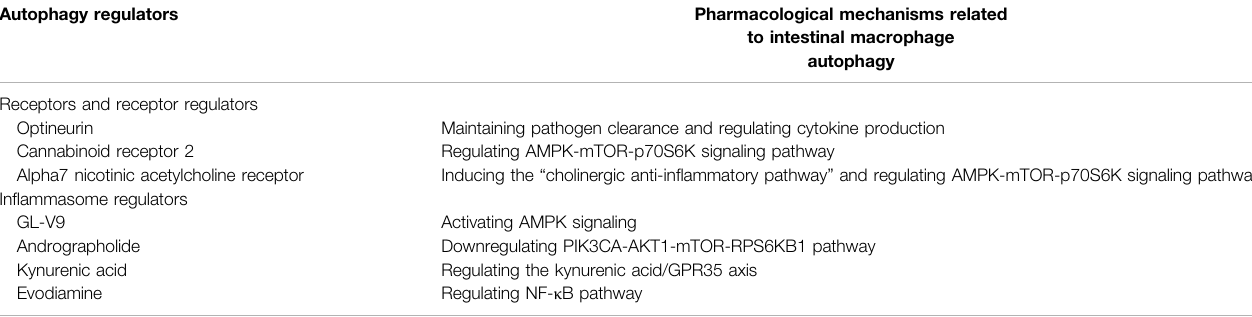
TABLE 1 | Pharmacological applications of intestinal macrophage autophagy regulators in the treatment of IBD. Autophagy